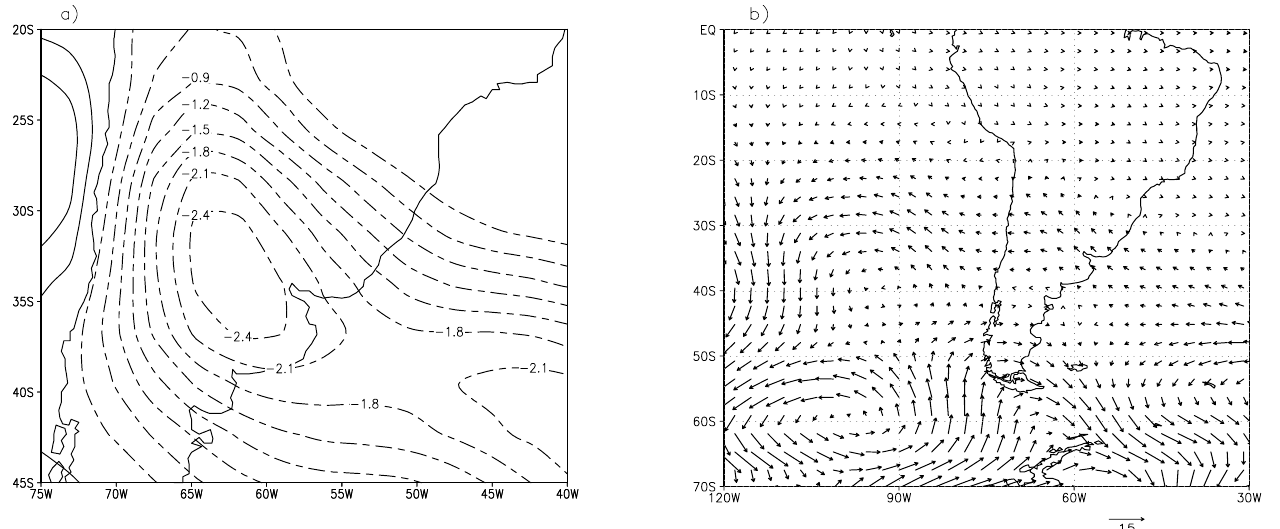
Figure 11 : Surface temperature anomalies (ºC) (a) and wind vector anomaly (ms -1 ) at 850 hPa (b), on Fig. 11. Surface temperature anomalies ( ◦ C) (a) and wind vector anomaly (ms − 1 ) at 850hPa (b) , on day 14 of integration, corresponding to day 14 of integration, corresponding to the mean winter basic state experiment with the forcing at the mean winter basic state experiment with the forcing at 40 ◦ E–20 ◦ S and 45 ◦ E–40 ◦ 40ºE-20ºS and 45ºE-40ºS